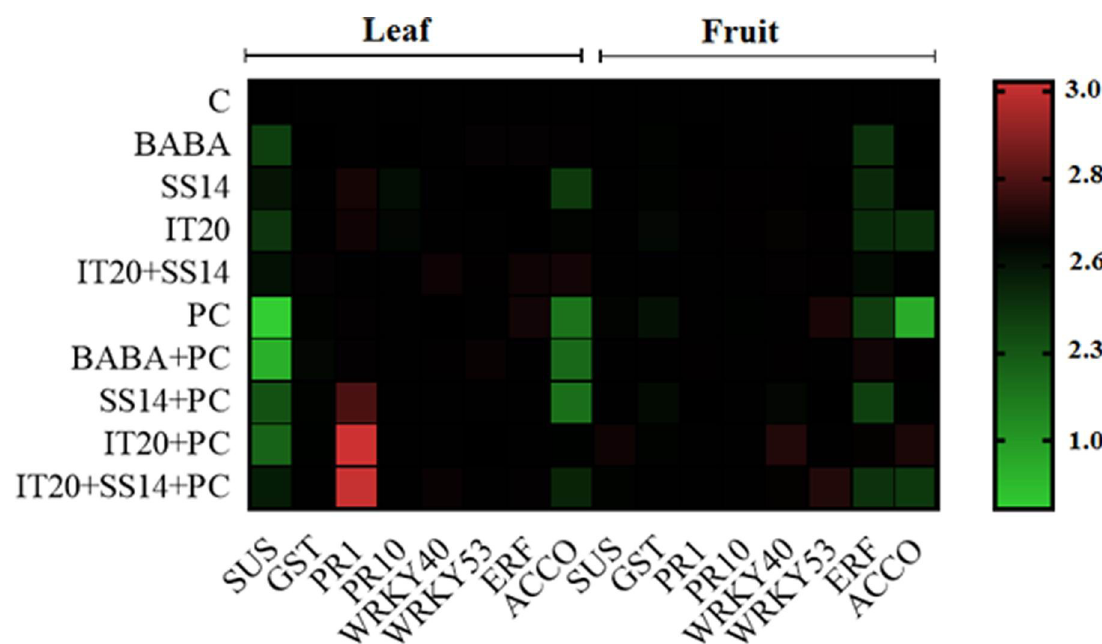
Fig 7. The tissue-specific expression of target genes of C . annuum visualized using log-2 fold change values in a heat map. The plants were treated with the chemical (BABA), biological ( S . vinaceusdrappus SS14 or S . rochei IT20) and combination (IT20+SS14) after inoculation with PC. Untreated and non-inoculated plants considered as control